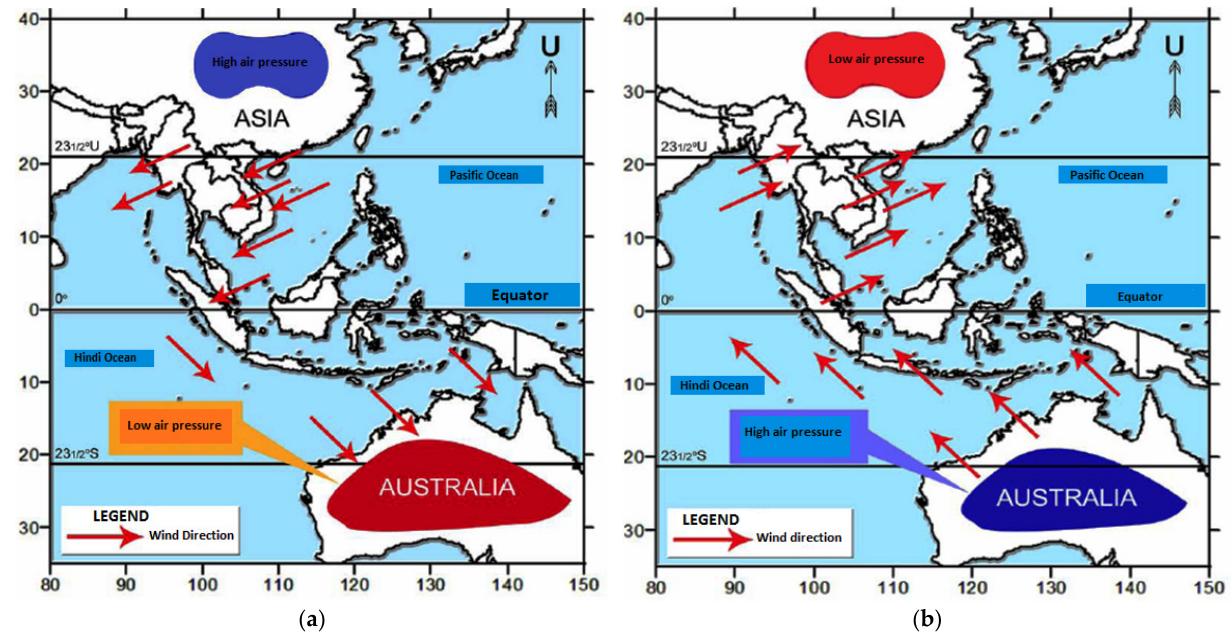
Figure 4. Process of the formation of the ( a ) northeast and ( b ) southwest monsoon seasons in Malaysia [44].